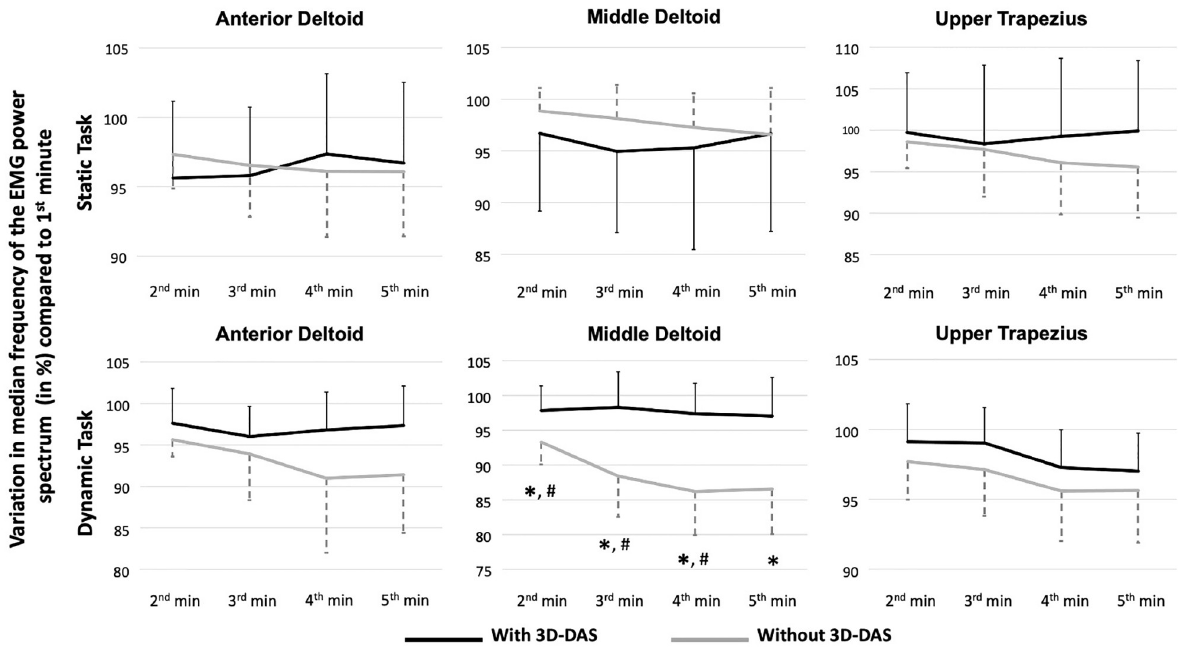
Fig 4. Mean variation in median frequency of the EMG power spectrum (in hertz (Hz); With standard deviation) compared to the first minute during the tasks with and without the dynamic arm support (3D-DAS) (n = 15 for each task). Significantly different (P < 0.05/7 or < 0.007 [Bonferroni adjustment]) compared to � the 1 st minute and # the previous minute when the task was performed without the